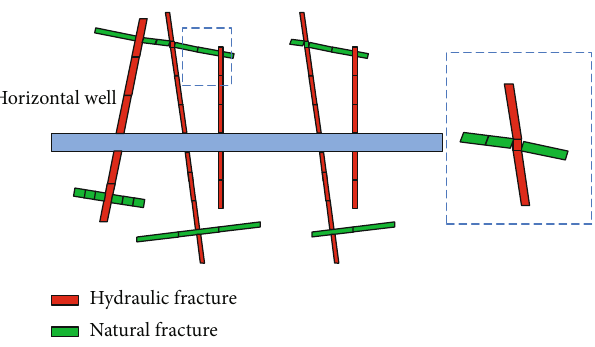
Figure 10: Sketch of unorthogonal fracture network.